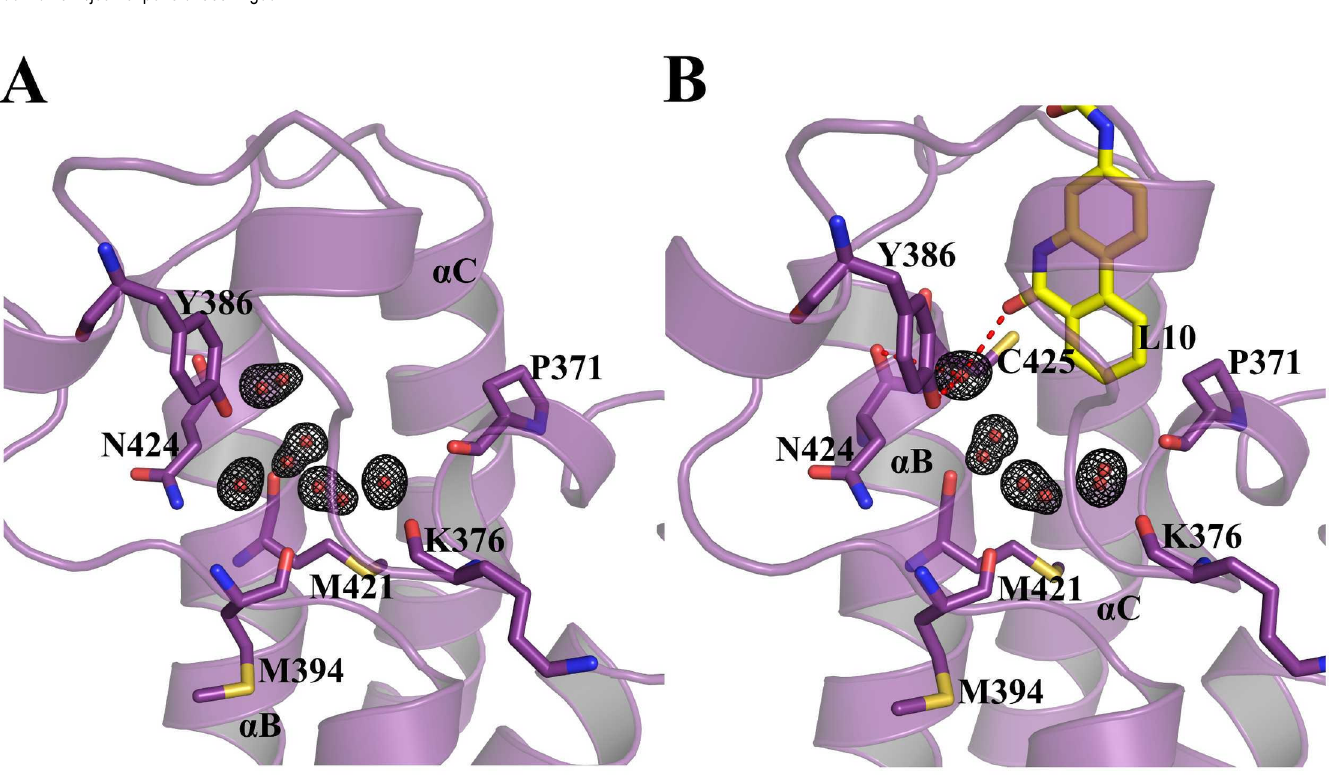
Fig 3. Alternate positions of conserved water molecules. (A) Among five conserved water molecules in the apo- form binding pocket, three are observed to have alternate positions. ( B) Three out of four conserved water molecules demonstrate alternate positions in the BD2-L10 complex. The ligand and selected residues are shown as sticks. Water molecules are shown as spheres. | 2Fo|-|Fc| map of water molecules contoured at 1.0 σ . The hydrogen bonds are shown as broken lines. doi:10.1371/journal.pone.0156344.g003 PLOS ONE | DOI:10.1371/journal.pone.0156344 May 31,